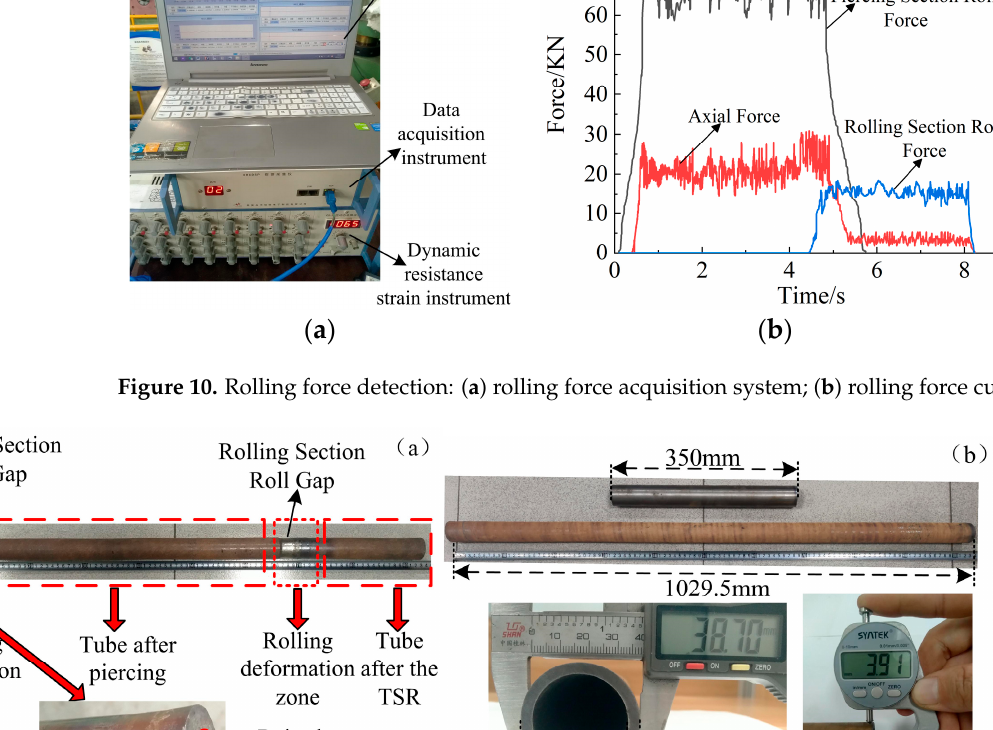
Figure 10. Rolling force detection: ( a ) rolling force acquisition system; ( b ) rolling force curve.